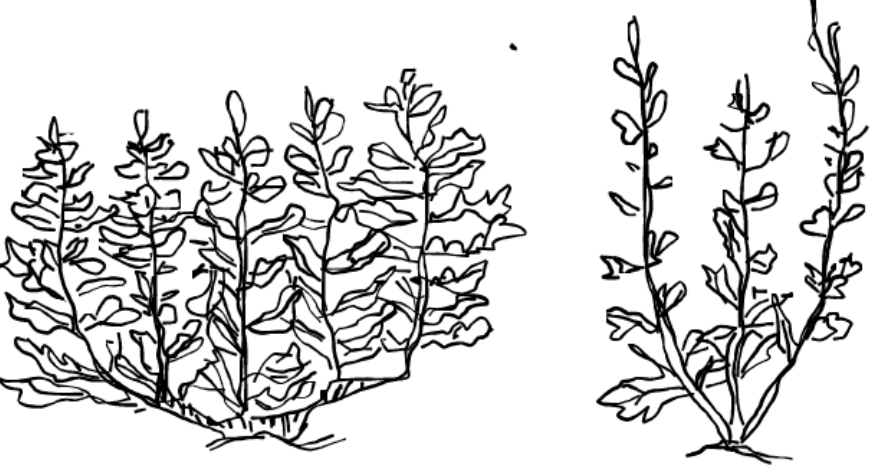
Figure 1. Growth habit, decumbent/ lasta ( left ) and ascending/ saigua ( right ). From Tapia et al. [6]. Cultivar is termed a set of plants that (a) has been selected for a particular trait or combination of traits, (b) is distinct, uniform, and stable in those traits, and (c), when propagated by appropriate means, retains those traits, according to the international nomenclature for plant crops [11].